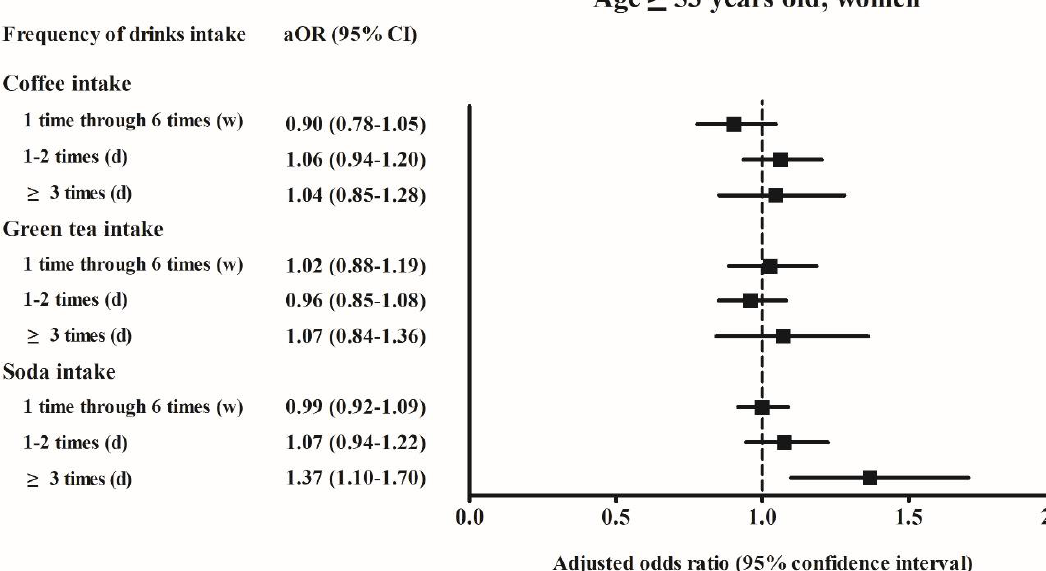
Figure 3. The adjusted odds ratio of the hyperuricemia according to the frequency of coffee/green tea/soda (soft drink) intake in the age ≥ 53 years old women. Fully-adjusted model (age, BMI, income, past medical histories, smoking, alcohol consumption, nutritional intake, frequency of coffee, green tea, and soft drink intake) was used.